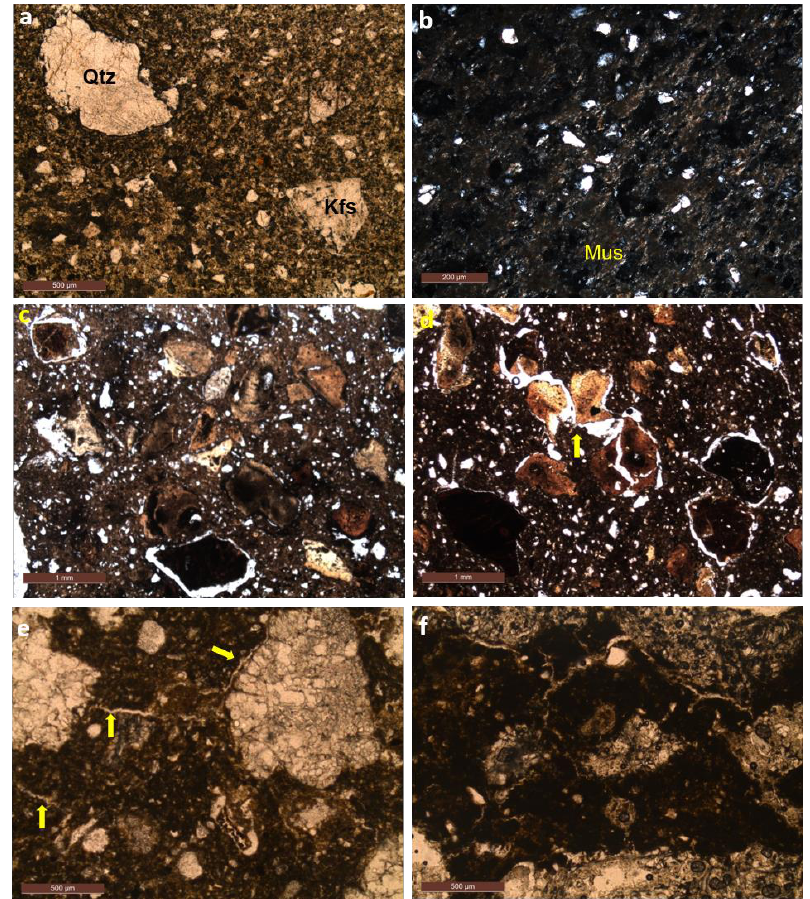
Figure 2. Photomicrographs of the clay samples without addition of absorbents showing the main characteristics of the clayey base material fired at 800 °C: ( a ) larger fragments of quartz crystals (Qtz) and feldspar (Kfs) supported by a clay matrix with small crystals of quartz and feldspar. Samples fired at 1000 °C: ( b ) darker clay matrix with fragments of rock (R × F) and quartz agglomerates (natural light). Samples containing attapulgite particles fired at 800 °C: ( c ) general characteristic of the sample showing the different behavior of the attapulgite particles with the heating, generation of a crack porosity around some particles and the presence of fractures in the particles of attapulgite and particles with darker central portion indicating initiation of a fusion process (natural light) and ( d ) detail of the thicker coronas and that the firing process generated the fracture and fragmentation of some attapulgite particles and formation of channels to a lesser extent fired at 1000 °C. ( e ) small channels connecting the perlite particles fired at 800 °C and ( f ) formation of channels in greater proportion and size for samples fired at 1000